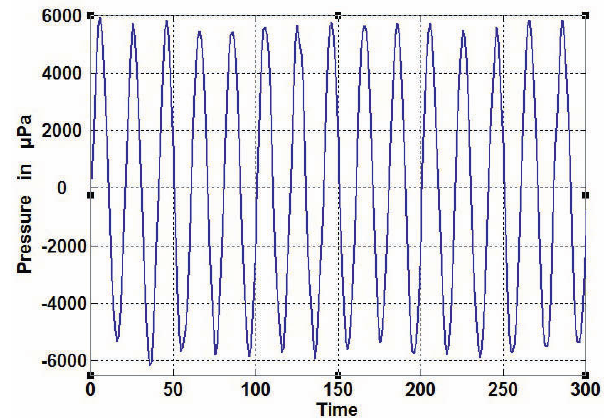
Figure 4. Denoised